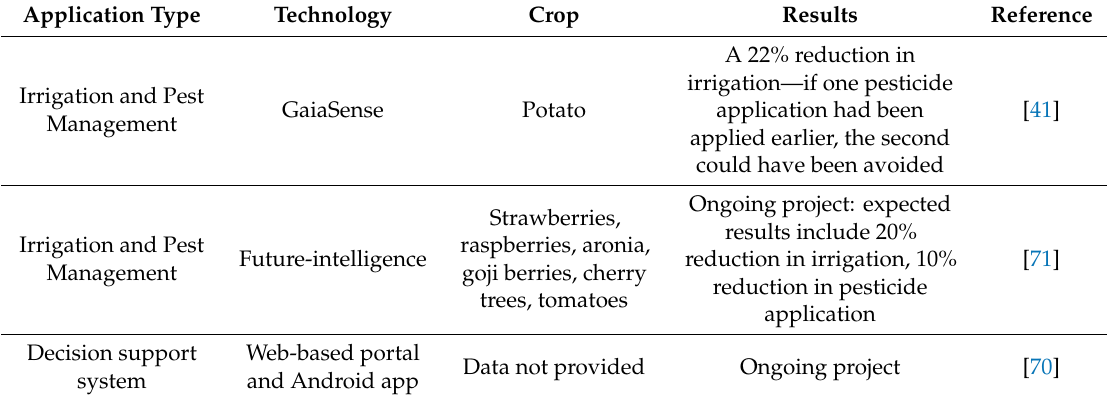
Table 2. Internet of Things (IoT) applications in Cyprus